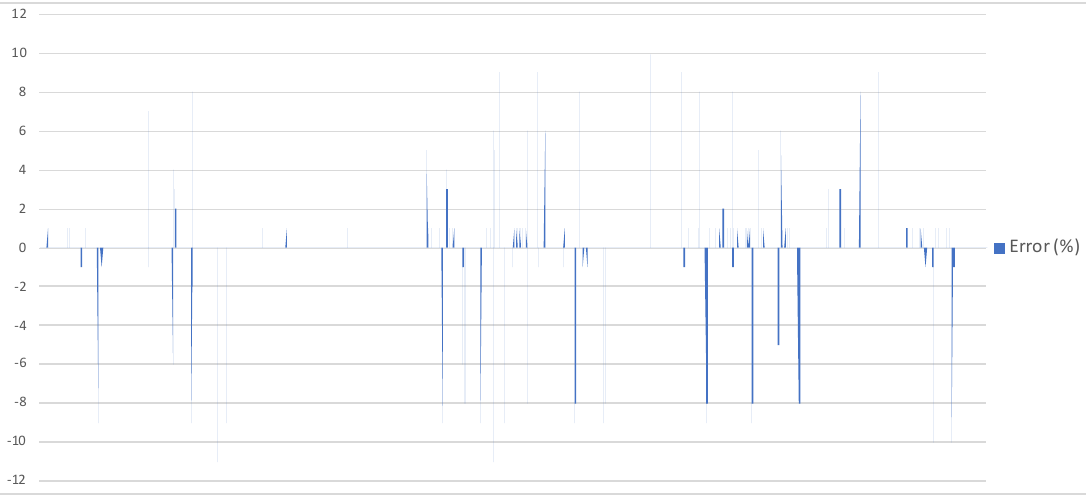
Figure 15. Error expressed as the difference of CPU use for a single compute node between the use of 10% (Figure 14) and 0%